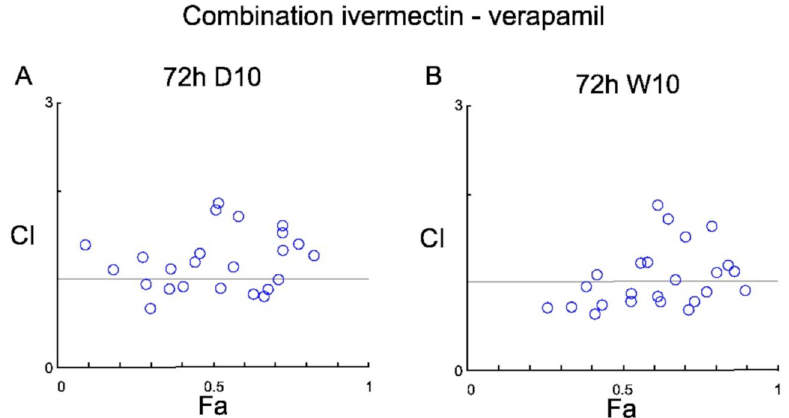
Fig 3. Combination Index plots for the anti- P . falciparum activity of Ivermectin (Ivm) in combination with Verapamil (Vpl) with an incubation time of 72h on asynchronous cultures of D10 (A) or W2 (B) strains. The data are representative of three independent experiments in duplicate for each